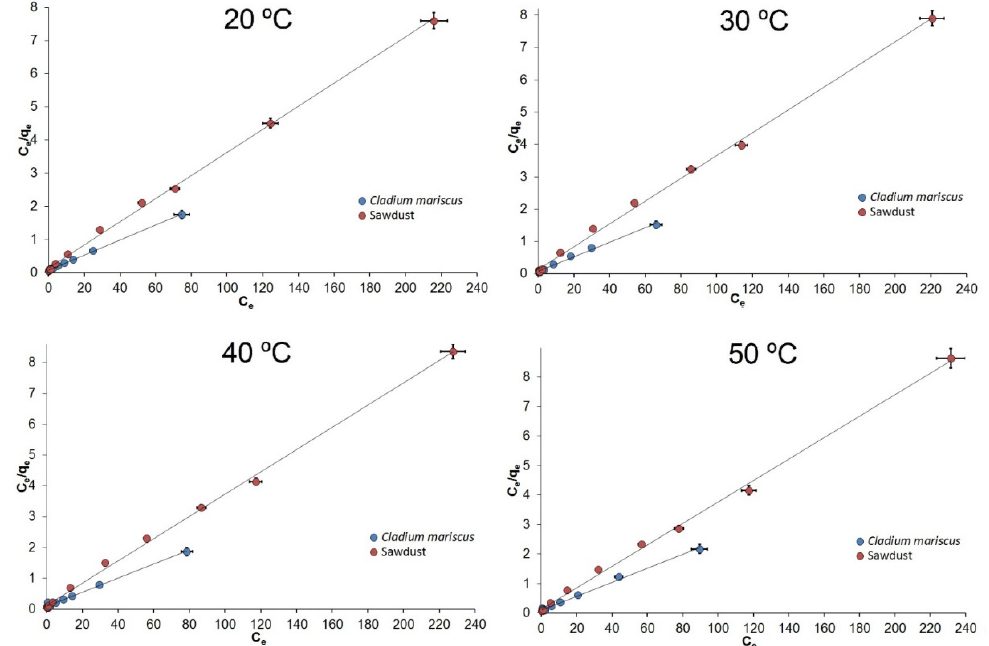
Figure 5. Langmuir isotherm model for BB3 adsorption on sawdust and Cladium mariscus saw-sedge at different temperatures.